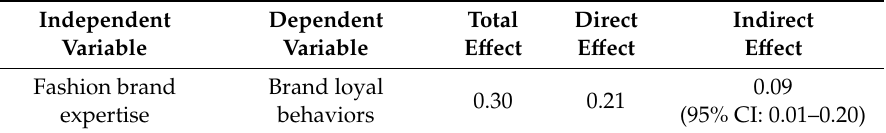
Table 4. Total, direct, and indirect effects of fashion brand expertise on brand loyal behaviors.